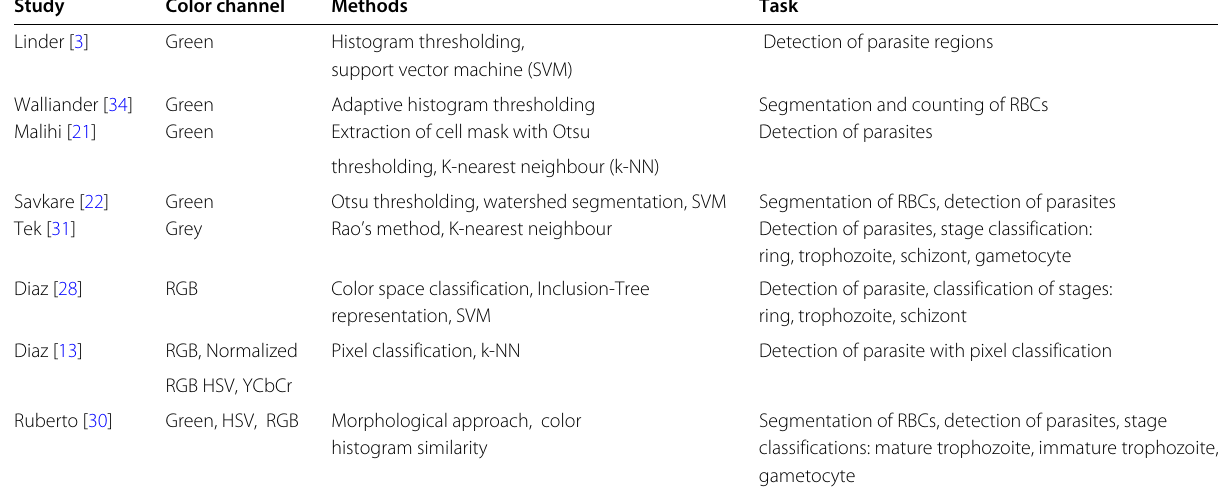
Table 2 Analysis